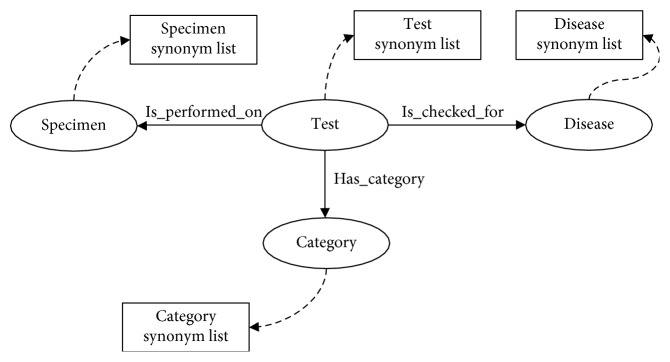
Ontology classes.